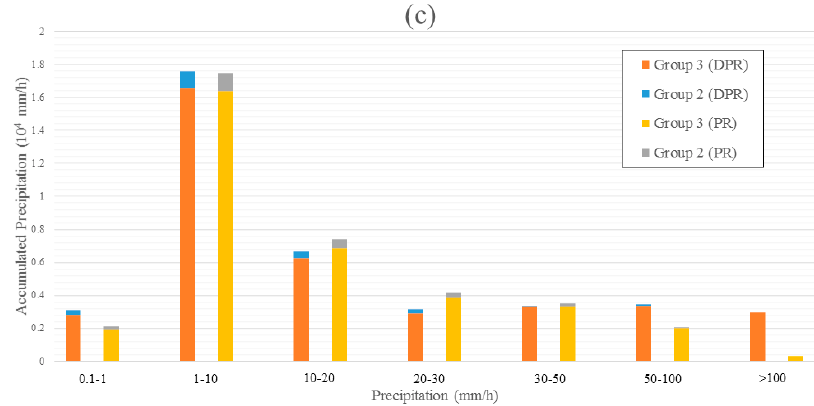
Figure 13. Histograms of accumulated precipitation based on coincident events between DPR and PR in Group 2 and 3: ( a ) coincident events occurring between 30°S and 32°S; ( b ) coincident events occurring between 2°S and 4°S; and ( c ) coincident events occurring between 6°N and 8°N.